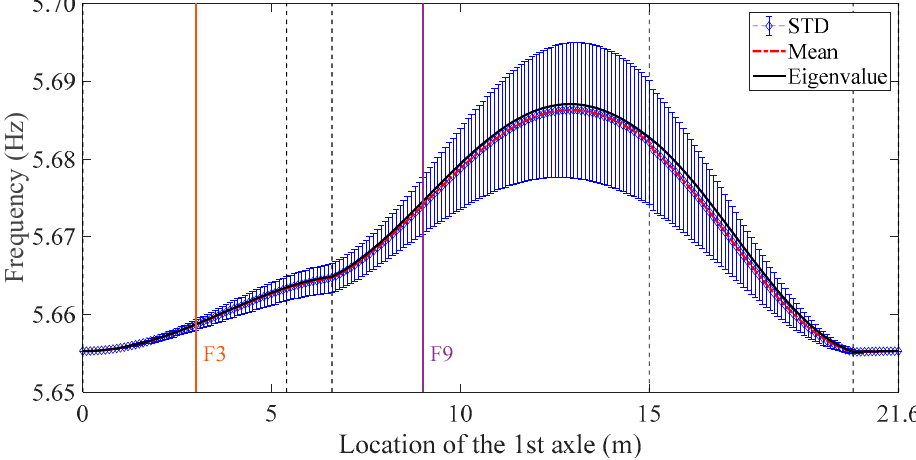
Figure 3. Bridge eigenfrequencies vs. location of the 1st axle on the bridge. In Figure 3, there are four vertical dashed lines indicating the 2nd and 3rd axles entering the bridge (5.4 and 6.6 m) and the 1st and 2nd axles leaving the bridge (15 and 20.4 m). Vertical solid lines signal the frequency F 3 , associated with the 1st axle located at 3 m and the frequency 𝐹 associated with the 1st axle at 9 m. The selected locations at 3 and at 9 m seek a compromise between a low sensitivity to the variability of the fleet, and a relatively far distance from singularities associated with the entrance and exit of axles.